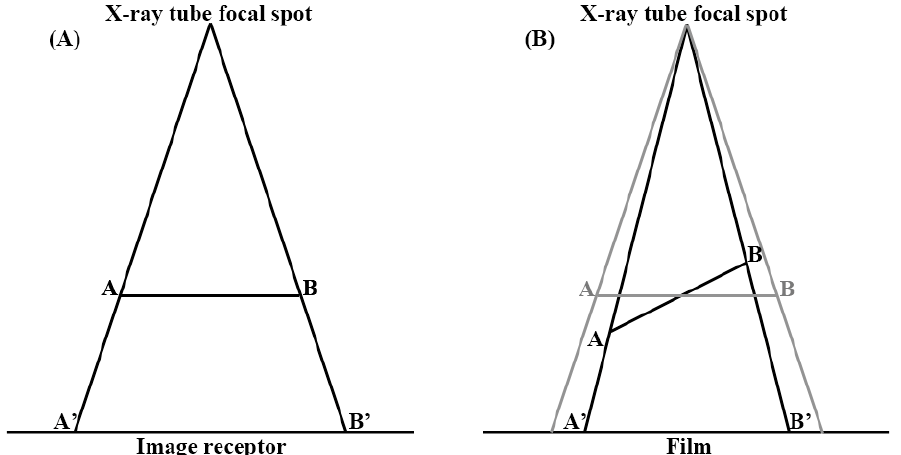
Figure 1. Magnification and distortion of the plane film. Objects further away from the focal spot are magnified, compared to those that are closer ( A ). Size and shape of image vary, depending on the amount of tilting ( B ).